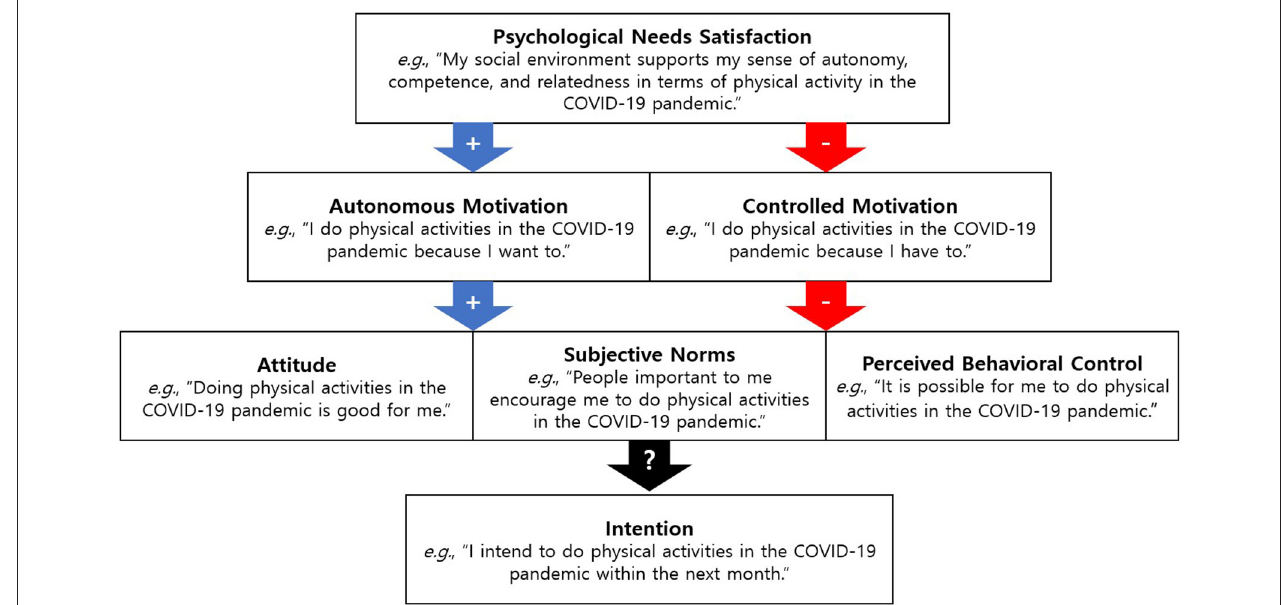
FIGURE 1 | The integrated model of Self-Determination Theory and Theory of Planned